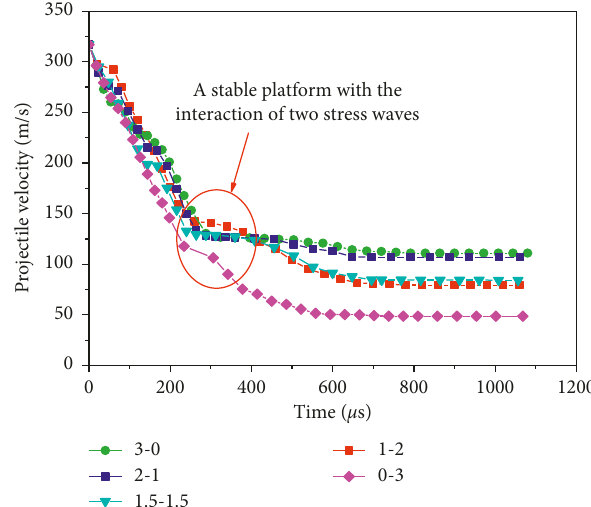
Figure 10: Velocity-time curves of a projectile with different steel liner layouts.